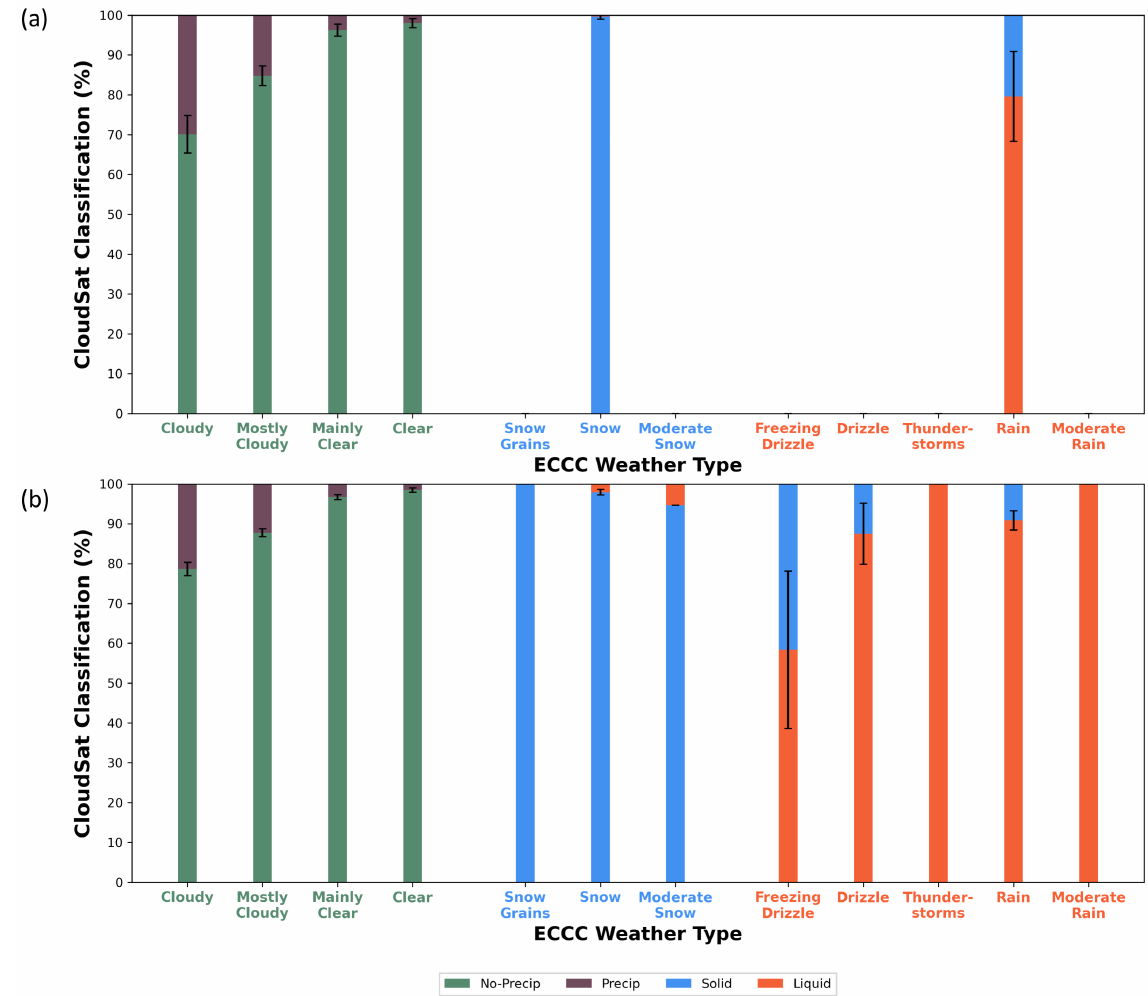
Figure 5. Detection of precipitation occurrence and classification of its phase, by CloudSat (colors) against ECCC present weather types recorded on the ground: ( a ) at Eureka; and ( b ) for all 26 stations across Canada. The bars closest to the x-axis represent CloudSat POD for each ECCC weather type. The sample size for each type is given in Table 4, and the POD for a given type is estimated only if its sample size is > 20. The error bars represent 95% confidence intervals on each estimate, assuming that the samples are